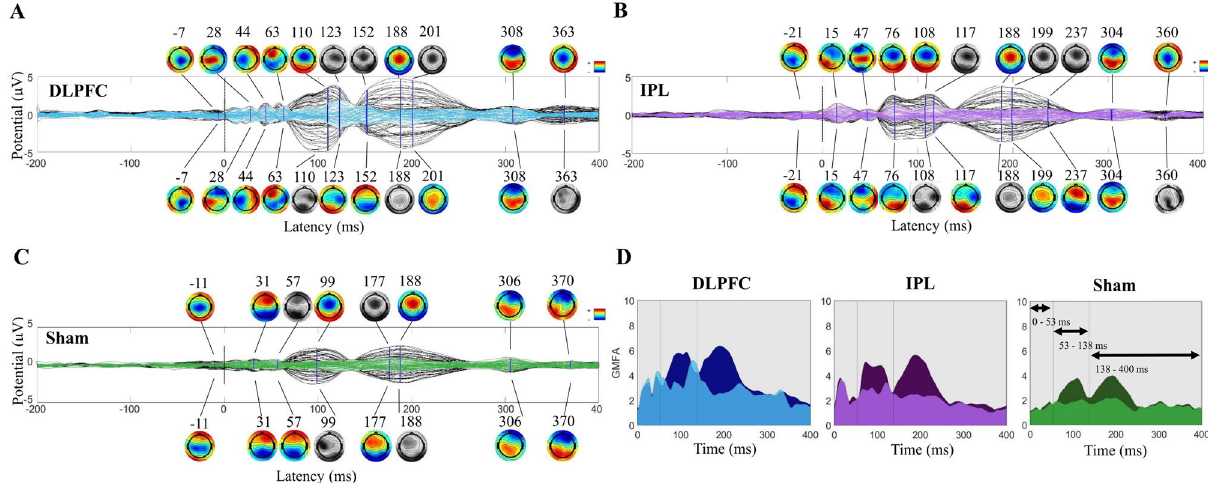
Figure 2. Group level impact of removing AEP in the younger cohort (N = 10). Topoplots are greyscale if no peak is present at the indicated latency. ( A ) DLPFC condition TEPs pre (black) and post (blue) removal of AEP components. Scalp topography pre (above) and post (below) at indicated latencies. ( B ) IPL condition TEPs/ topographies pre (black/above) and post (purple/below) removal of AEP components. ( C ) Sham stimulation condition TEPs/topographies pre (black/above) and post (green/below) removal of AEP components. ( D ) Global mean field potential (GMFP) area under the curve plots pre (darker) and post (lighter) AEP removal in three time-windows, defined by sham GMFP peak activity pre-AEP removal.